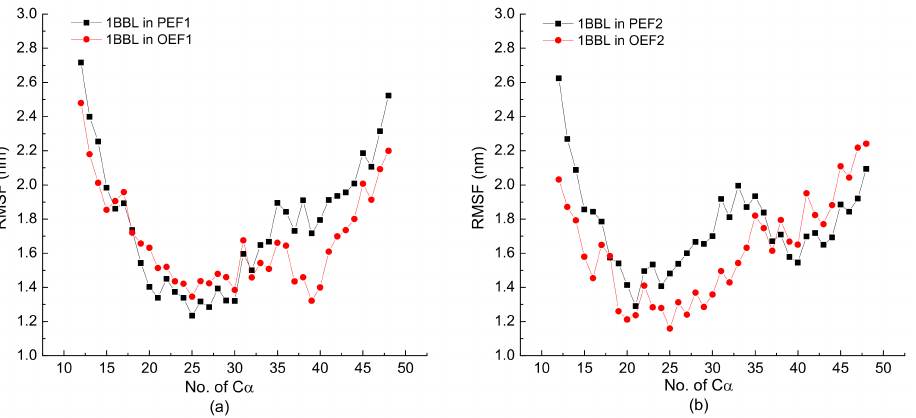
Figure 5. (Color online) The root mean square fluctuation (RMSF) of skeleton C α atoms in the protein 1BBL exposed in the pulsed or oscillating electric fields with a frequency of ( a ) 1000 MHz and ( b ) 2000 MHz, respectively.